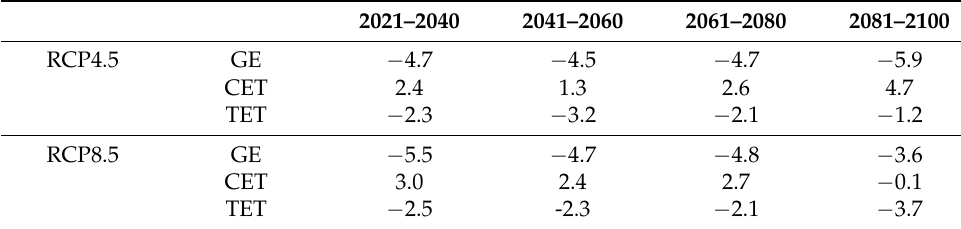
Table 1. Quantified contribution of VR to ET in different stages during 2021 − 2100 on the LP.